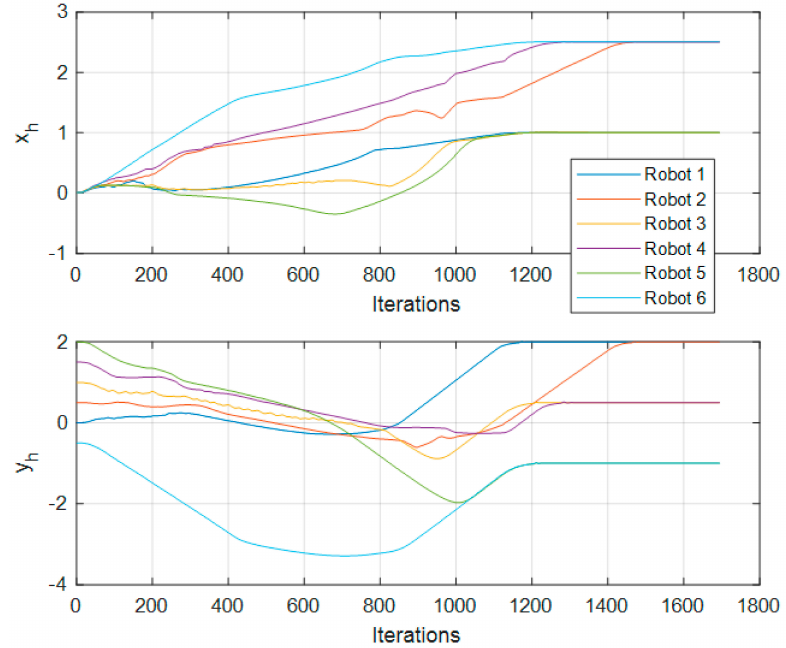
Figure 11. Trajectories along iterations in the 6-robot